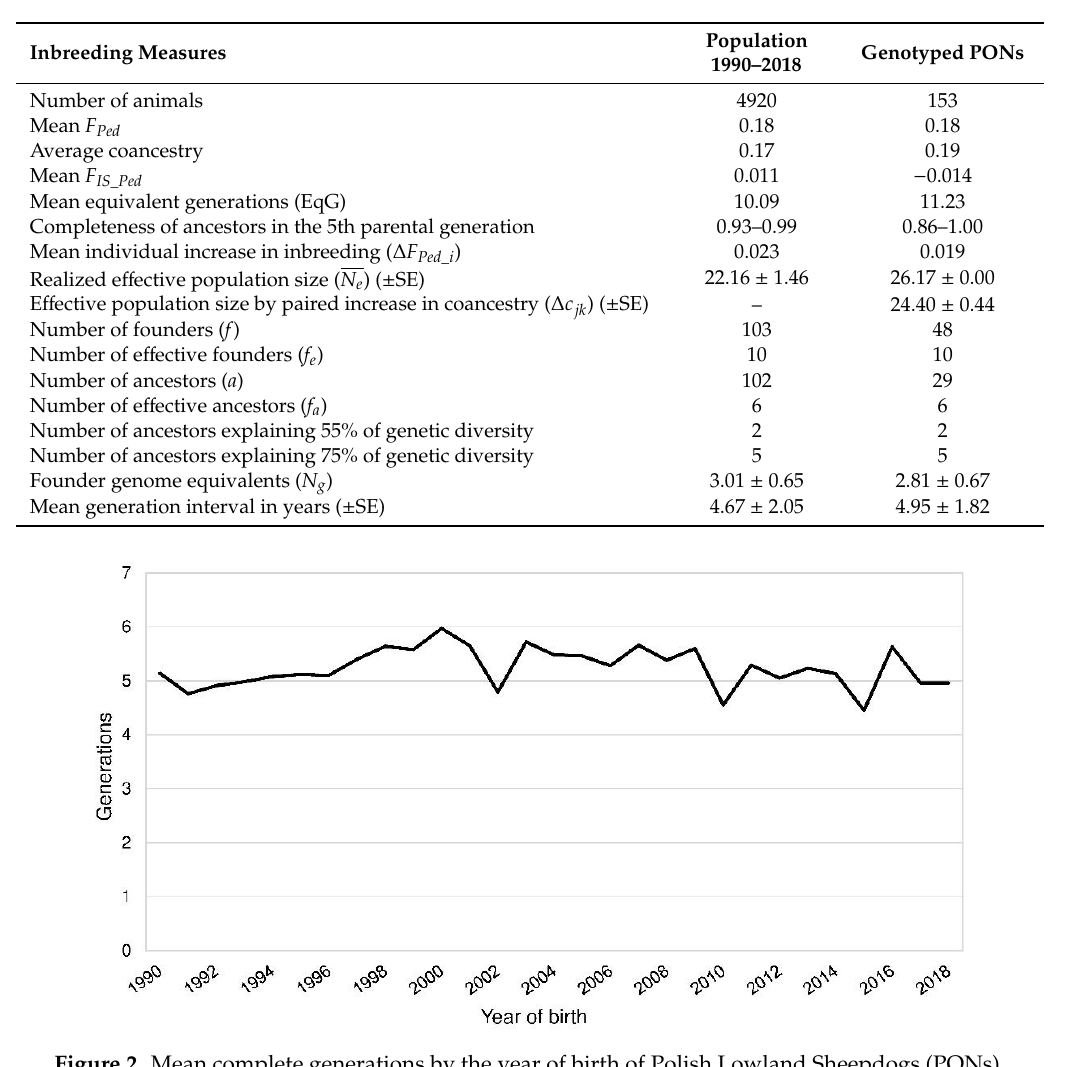
Table 2. Results of the pedigree-based inbreeding measures calculation for the reference population born from 1990 to 2018 and the genotyped Polish Lowland Sheepdogs. All available pedigree data included 8628 animals.